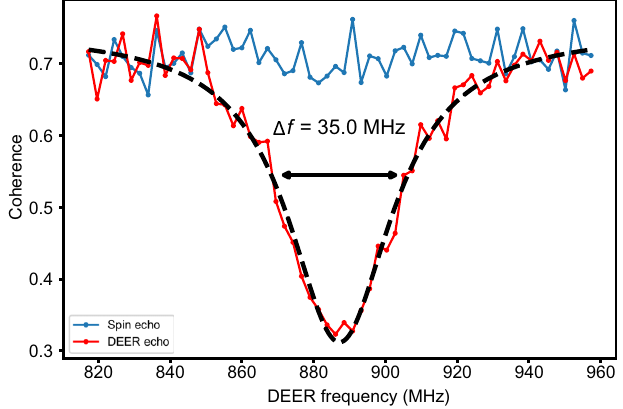
FIG. 10. DEER frequency